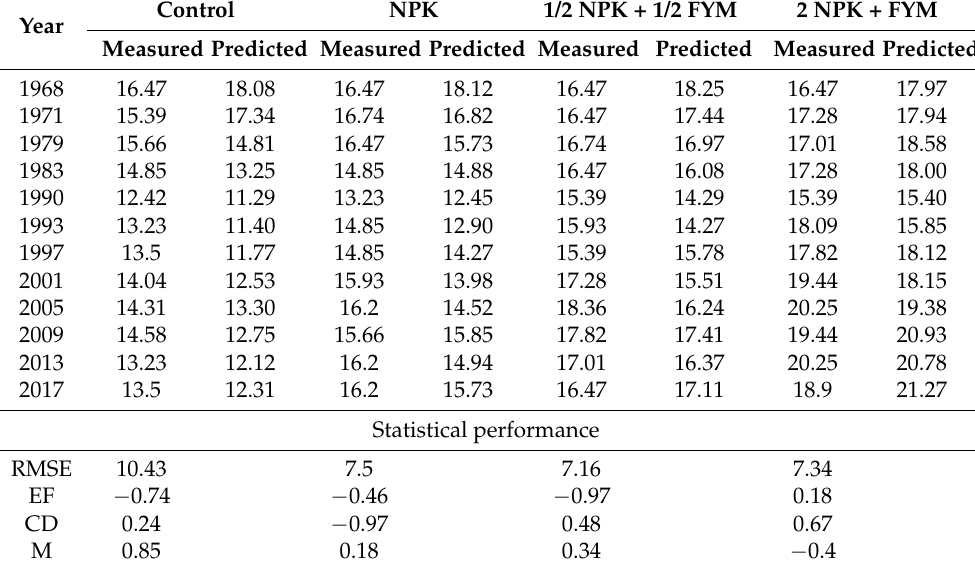
Table 4. Comparison of simulated and calculated data on the dynamics of C reserves (t · ha − 1 ) for four variants of long-term experiment and statistical evaluation of modelling. RMSE—root-mean-square error, EF—simulation efficiency, CD—coefficient of determination, M—mean difference, based on Smith et al.